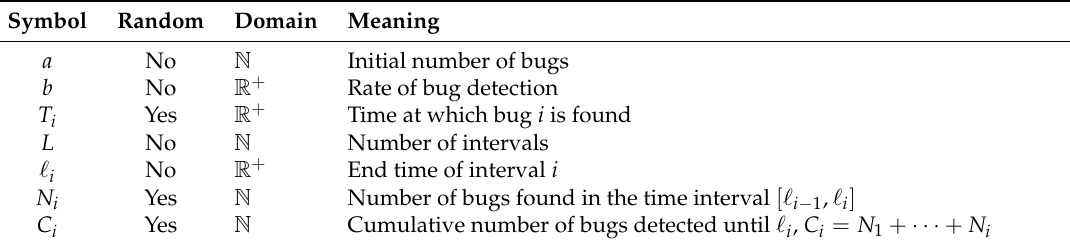
Table 1. Symbols used in the Jelinski–Moranda model for grouped